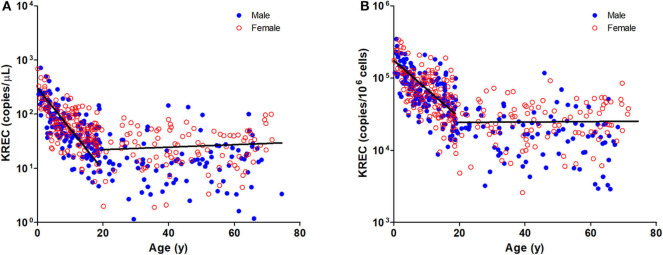
Dot Plot showing KREC copies/μL blood (A) and TREC copies/106 cells (B) among the study age groups. Blue full circles represent healthy males and red empty circles represent healthy females. A significant inverse correlation was observed between KREC levels and pediatric age groups (Pediatric: r = −0.6577, p < 0.0001 for copies/μL and r = −0.6241, p < 0.0001 for copies/106 cells; Adult: r = 0.0903, p = 0.2216 for copies/μL and r = −0.0171, p = 0.8176 for copies/106 cells).